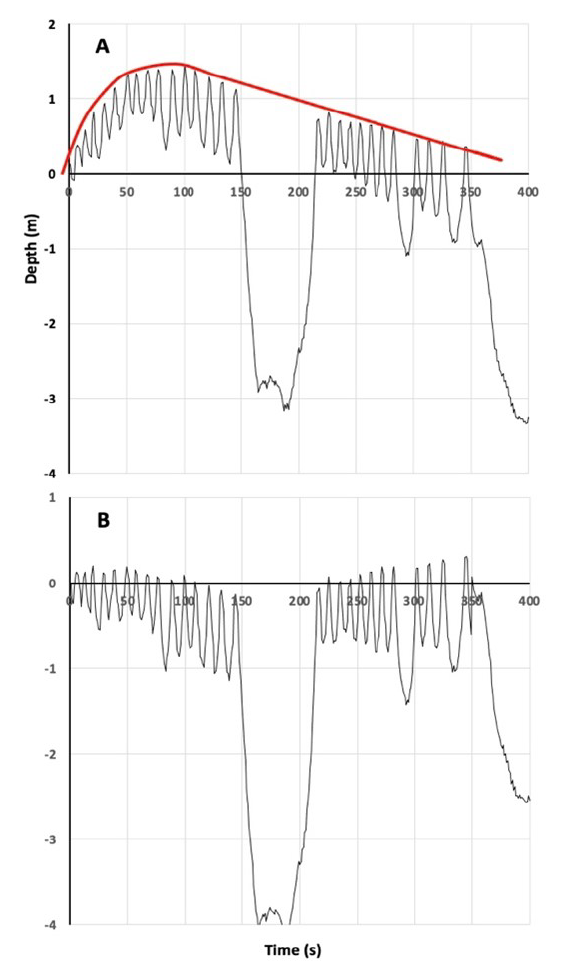
Figure 2: Upper panel: Example of two subsequent surface event where the inertia of the pressure transducer still affects the zero m detection of the surface of the second surface event. Lower panel: The same event after compensation of the surface detection has been implemented. From AcousondeTM on Asgeir August